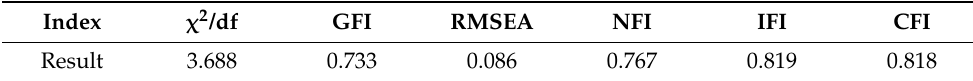
Table 6. Model fitting